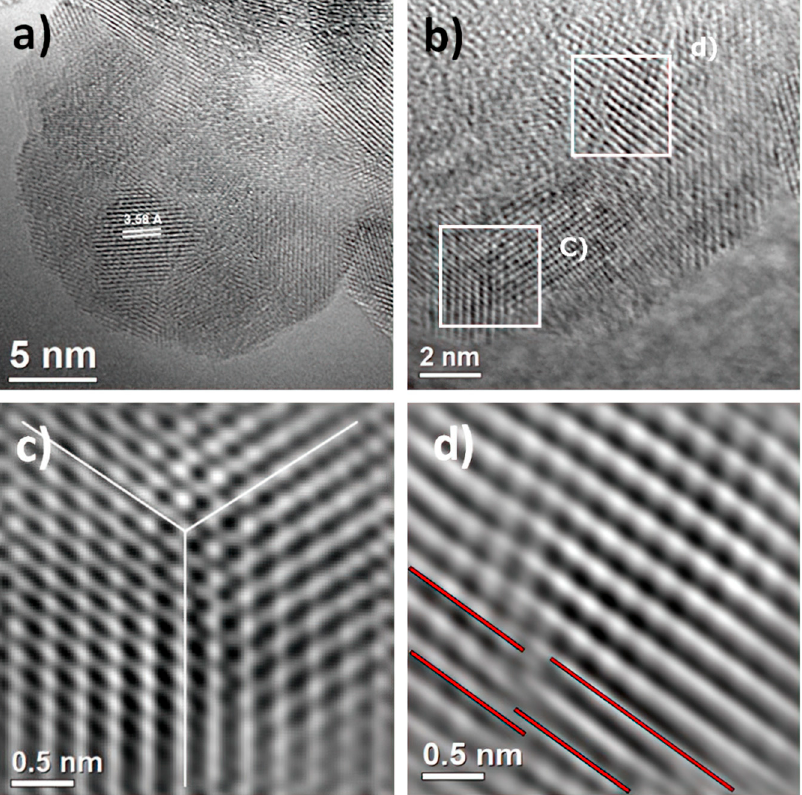
Figure 3. High-resolution transmission electron microscopy (HRTEM) of as-prepared sample. ( a ) Polycrystalline anatase phase with [101] projection; ( b ) the edge of the sample shows the formation of structural defects, indicated by white boxes, ( c ) such as twinning or homophases; ( d ) existence of dislocations in the sample.